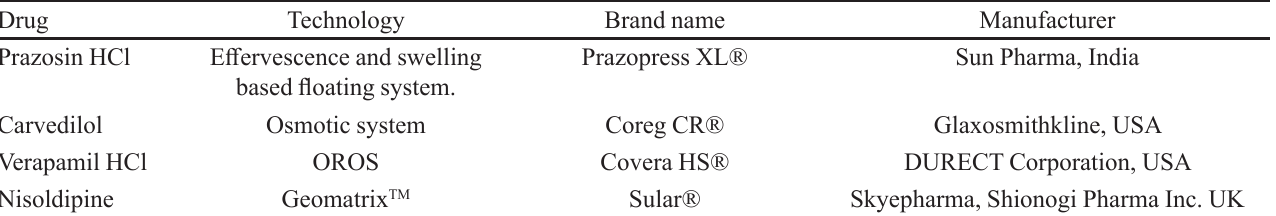
TABLE III - Marketed products of GRDDS for antihypertensive drugs (Srikanth, 2011; Awasthi, Kulkarni, 2016)